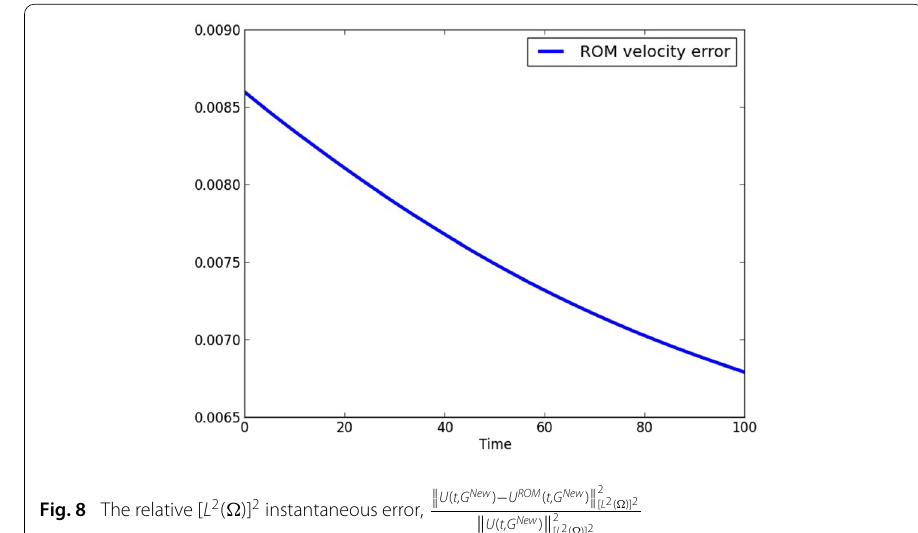
Fig. 8 The relative [ L 2 ( (cid:2) )] 2 instantaneous error,